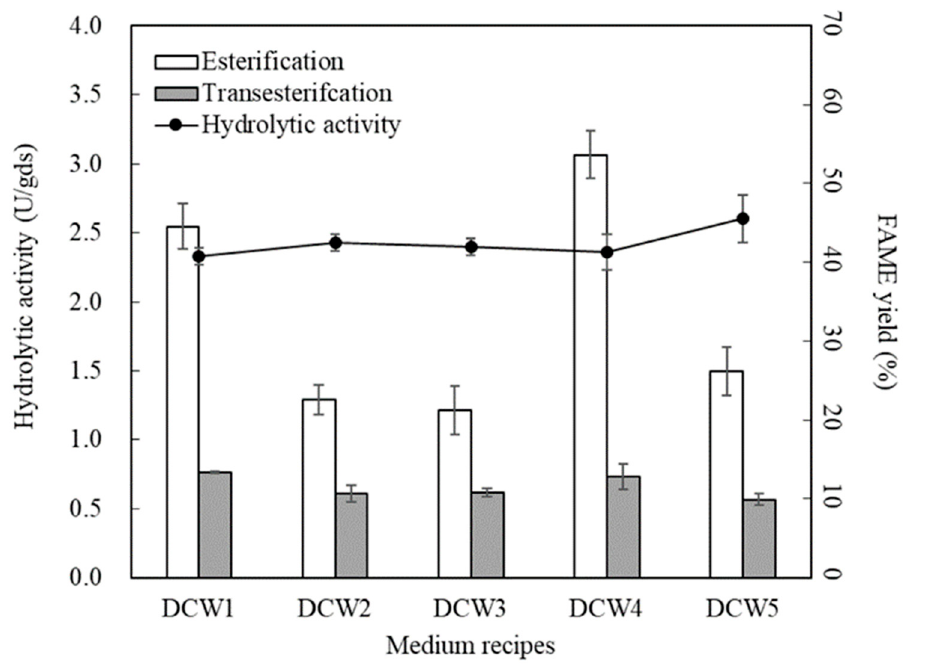
Figure 1. Hydrolytic, transesterification and esterification activities of whole-cell lipase produced by the selected fungal Aspergillus sp. MS15 cultured in decanter cake waste-based media.